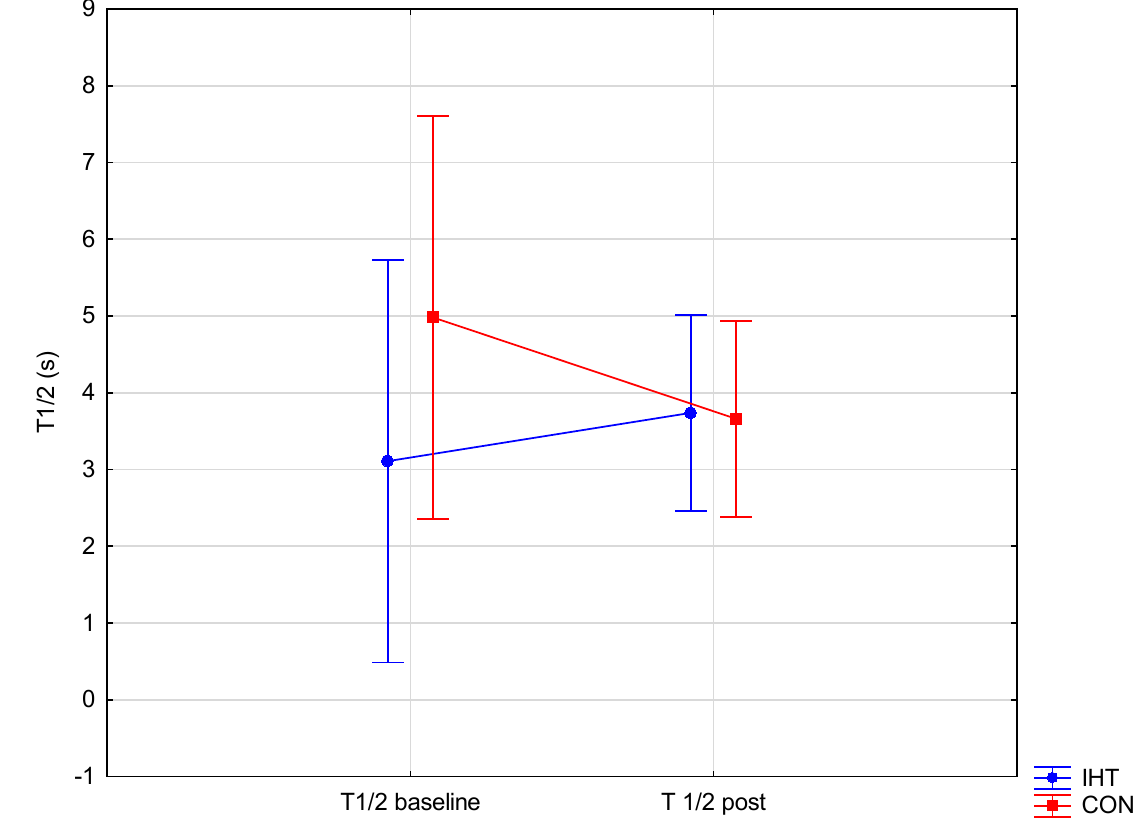
Figure 5. Half-time of total red blood cell aggregation (T1/2) in rowers training in the hypoxia (intermittent hypoxic training, IHT) and normoxia (control, CON) conditions before and after the intervention.